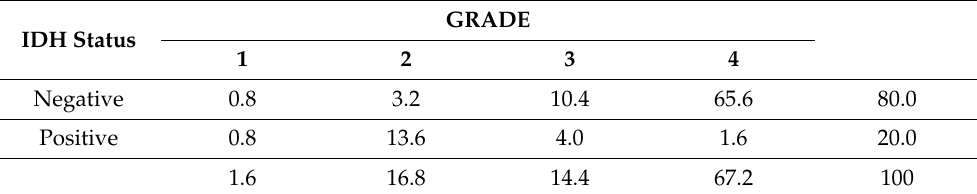
Table 3. Pearson correlation test showing if the variables grade and IDH are